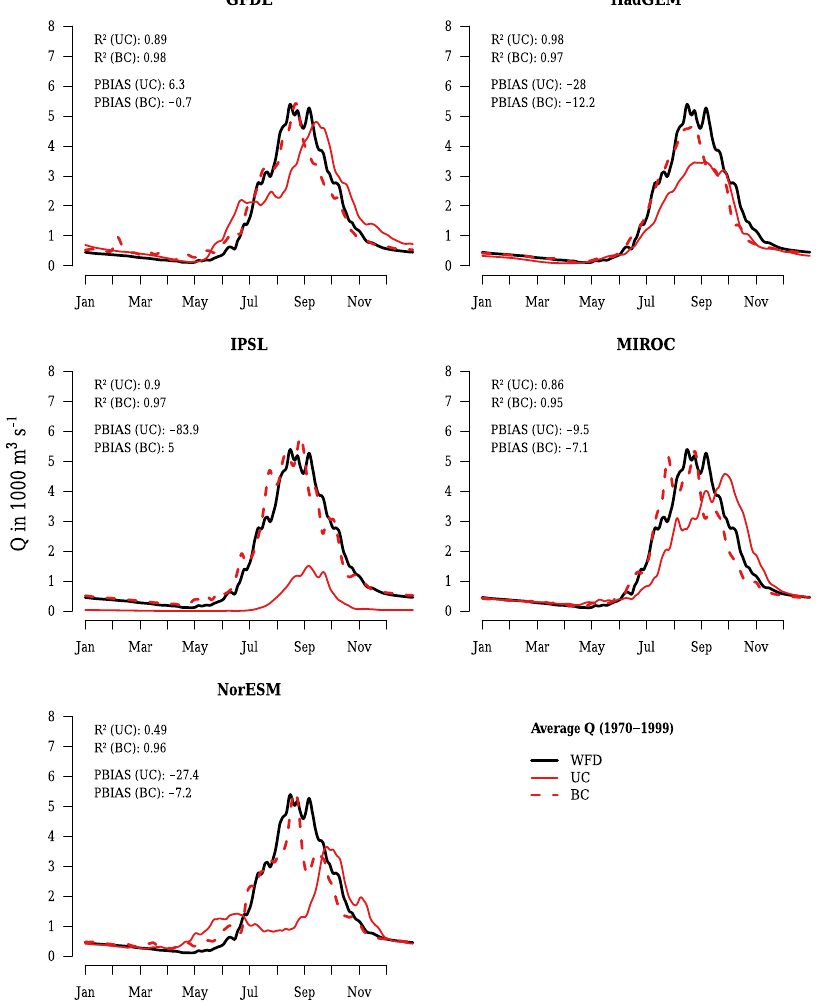
Figure 3. Annual cycle of average daily uncorrected (UC) and bias-corrected (BC) simulated discharges at gauge El Diem using Earth system model input and WATCH Forcing Data (WFD) in the reference period